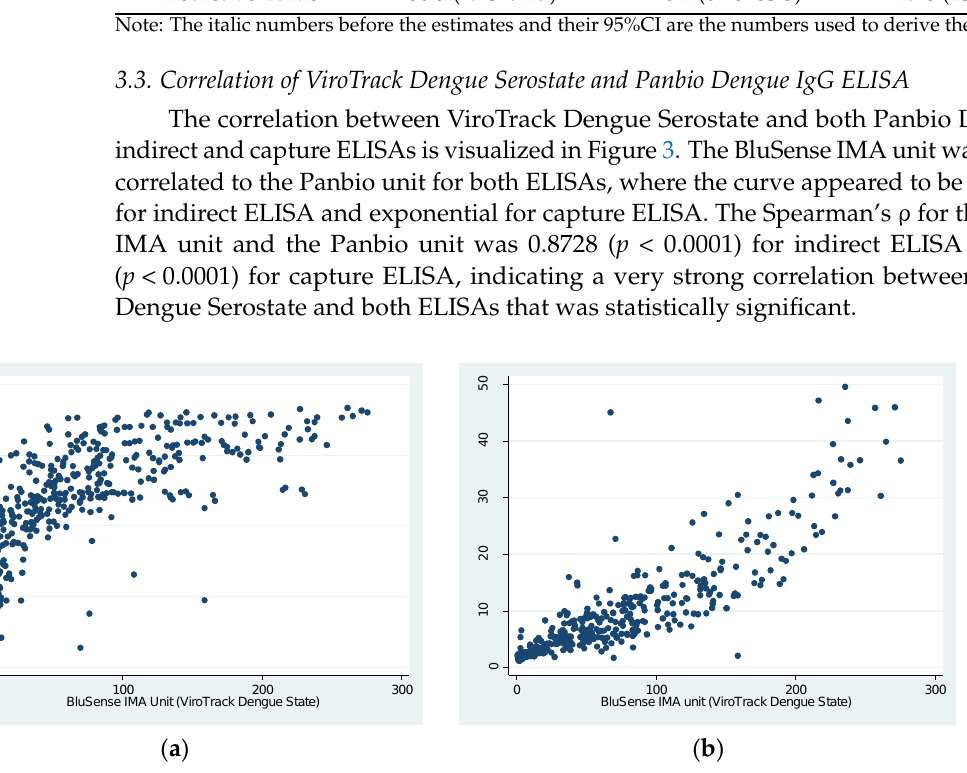
Figure 3. Correlation between the ViroTrack Dengue Serostate’s BluSense IMA Unit and Panbio Unit of ( a ) Panbio Dengue IgG indirect ELISA and ( b ) Panbio Dengue IgG capture ELISA.